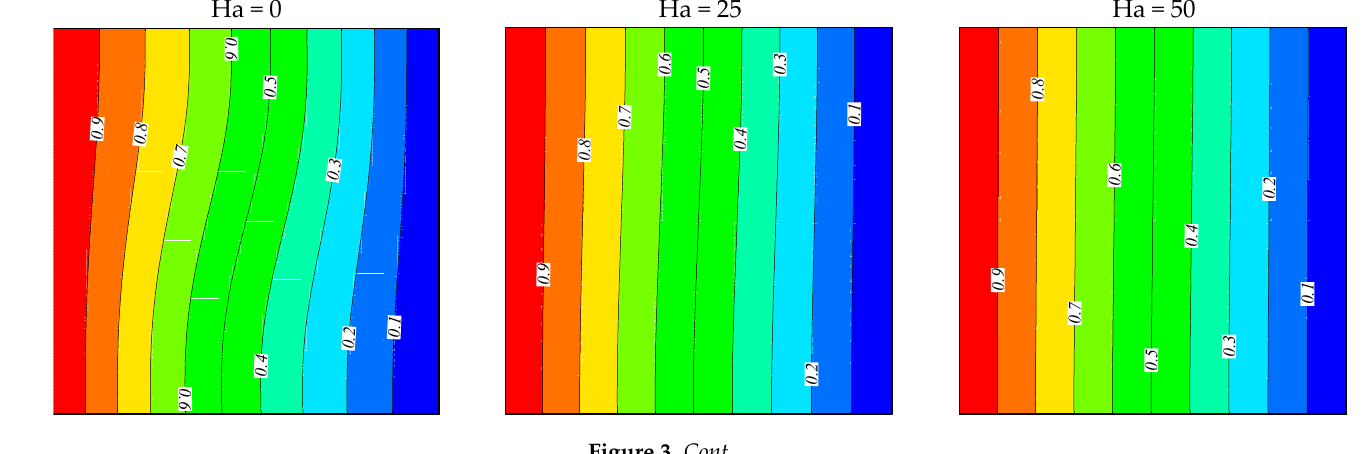
Figure 2. Streamline contours for different values of Rayleigh and Hartmann numbers when N = 1, m = 3, and